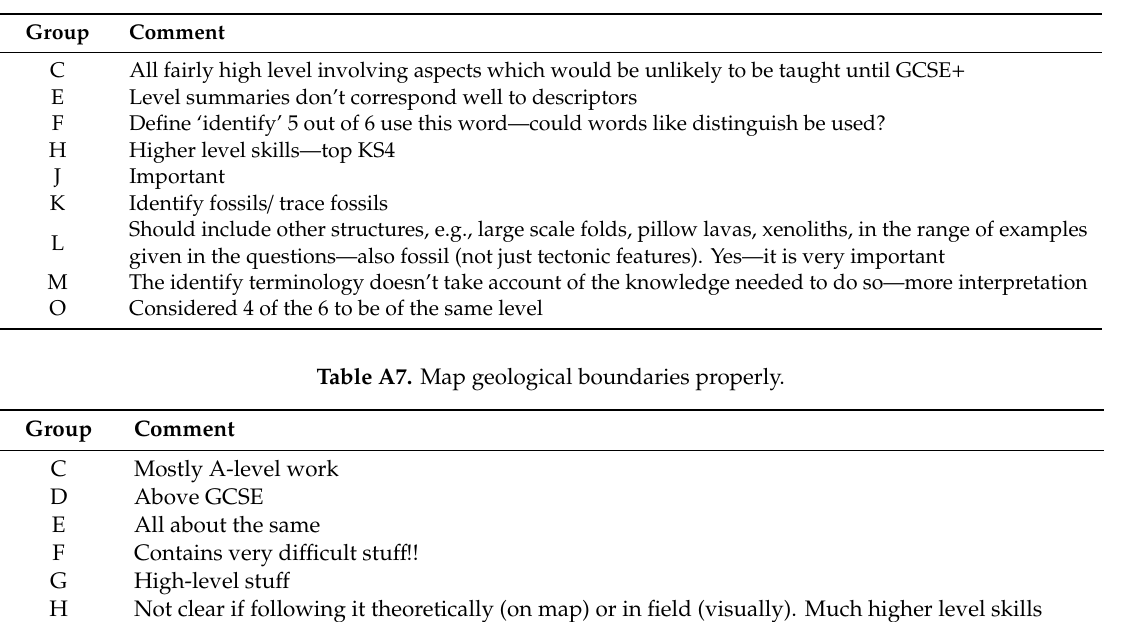
Table A6. Identify exposed structures correctly.